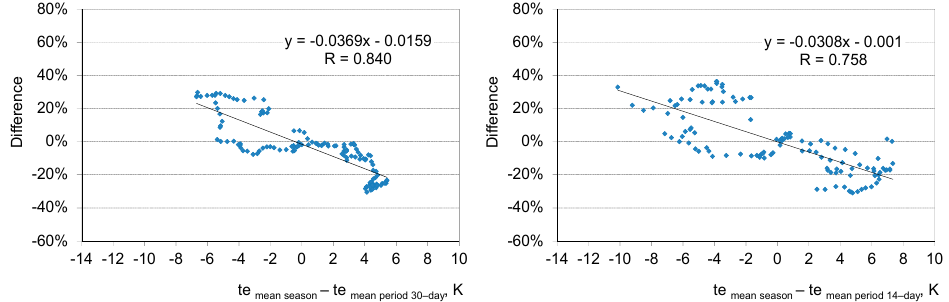
Figure 11. Correlation between the seasonal heat demand difference in the school building with large internal heat gains and the external temperature difference (mean for the season and mean for each short period) for the 30-day measured periods (on the left) and for the 14-day measured periods (on the right); only for periods with R ≥ 0.6.